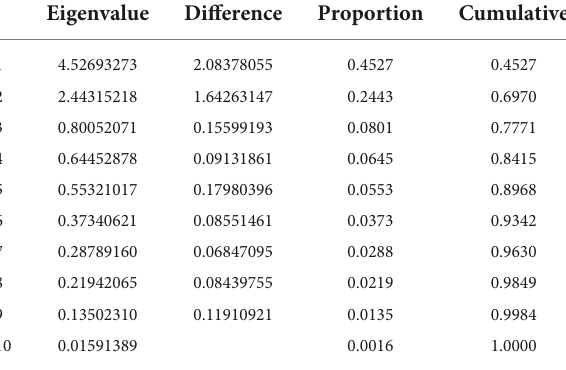
TABLE 5 Eigenvalues of the correlation matrix: Total = 10 Mean = 1.